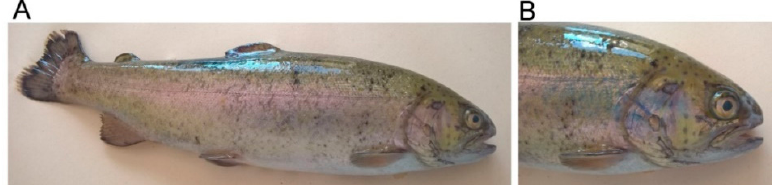
Figure 1. A rainbow trout ( Oncorhynchus mykiss ) naturally infected with A. sobria . ( A ) Symptoms of health disorders were manifested as skin infection with visible dermal lesions on the body and erosions on the tail and dorsal fins. ( B ) Dermal lesions were especially found on the trout’s mouth, around the eyes, and along the operculum—the cover of the gills.